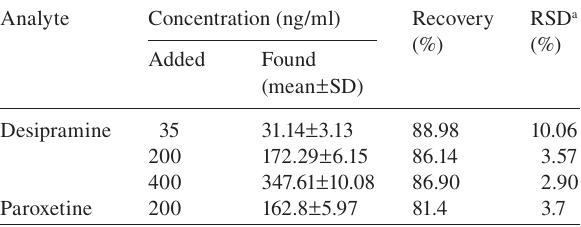
Absolute recovery of desipramine and IS from plasma.